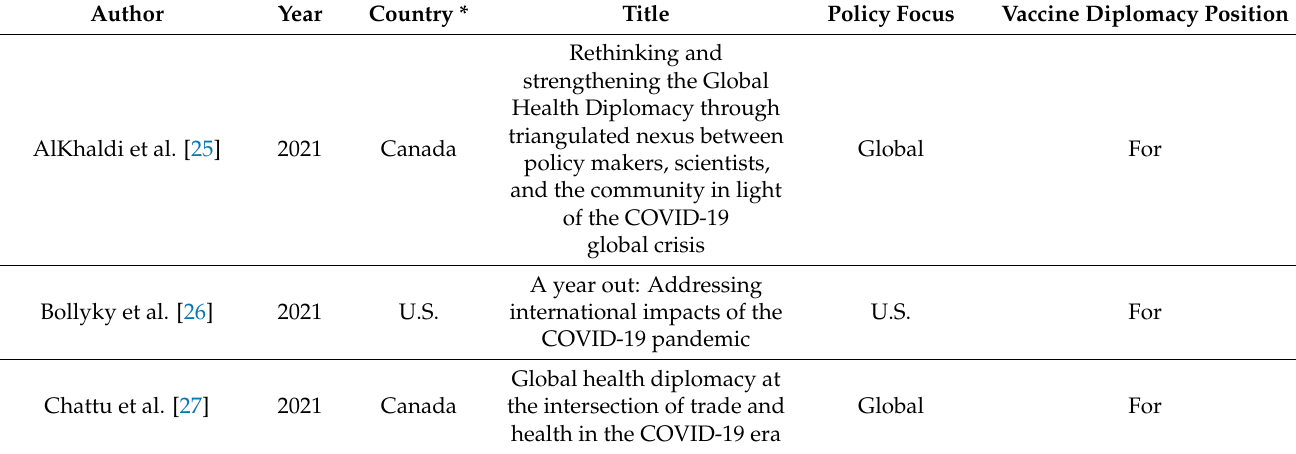
Table 3. Key articles included in the